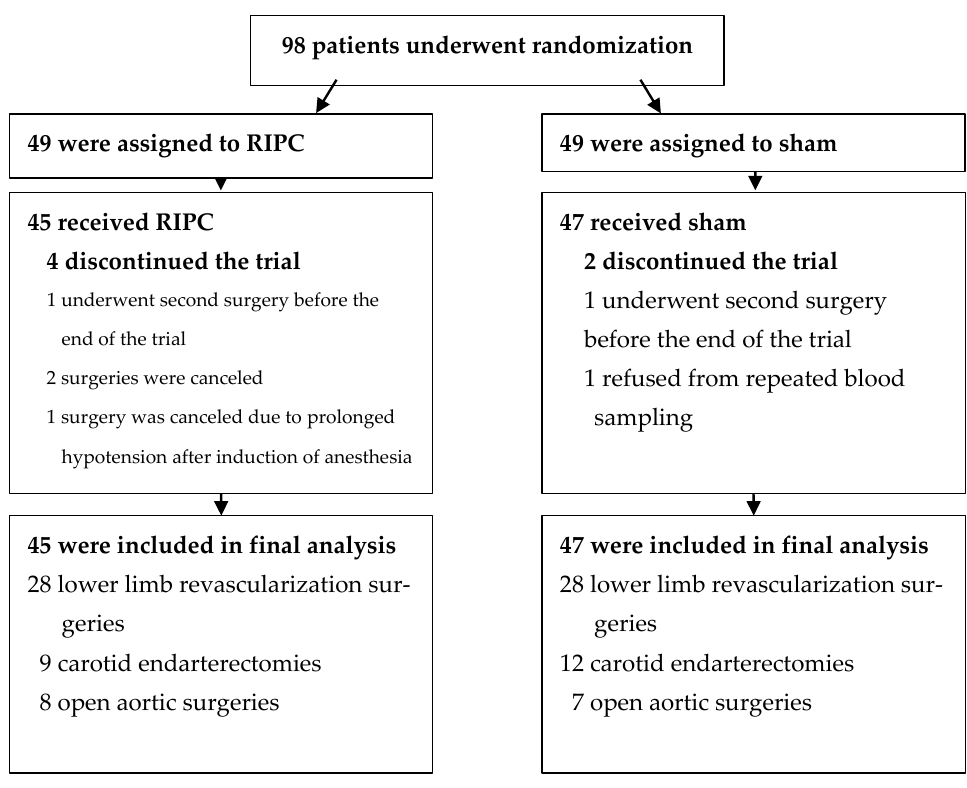
Figure 1. Patients’ flow chart The median time from the end of the intervention to the beginning of surgery did not differ significantly ( p = 0.057) between the RIPC (36 min, IQR 21 – 46 min) and the sham group (25 min, IQR 15 – 38 min). The baseline characteristics of patients did not differ sig- nificantly between the study groups (Table 1).